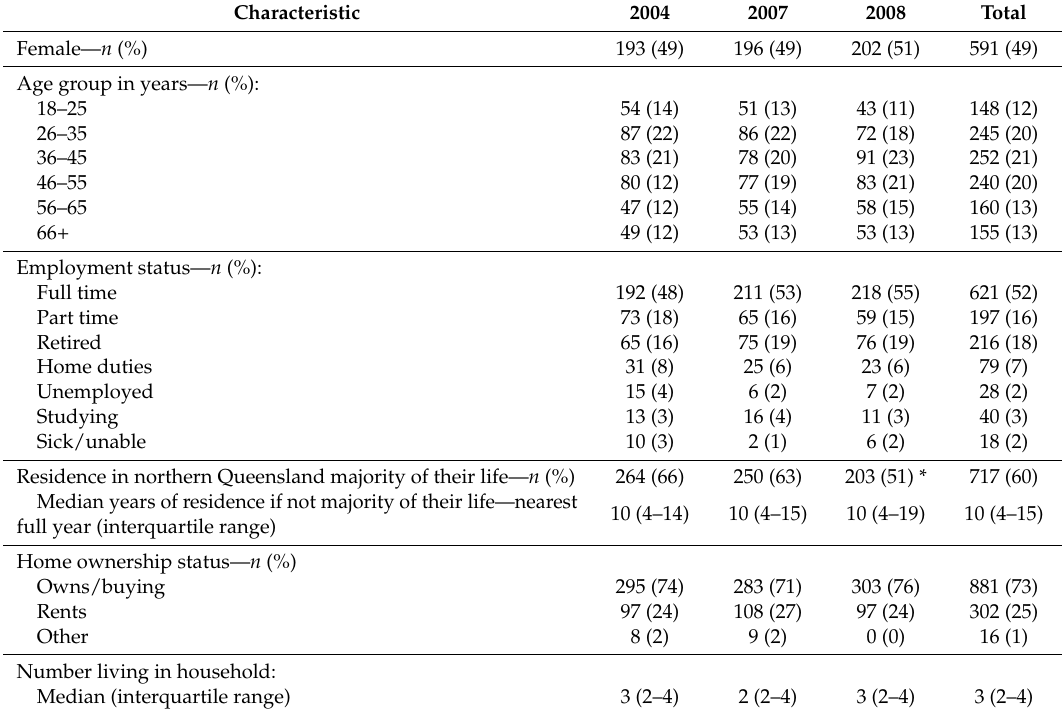
Table 1. Participant characteristics in northern Queensland—2004, 2007, and